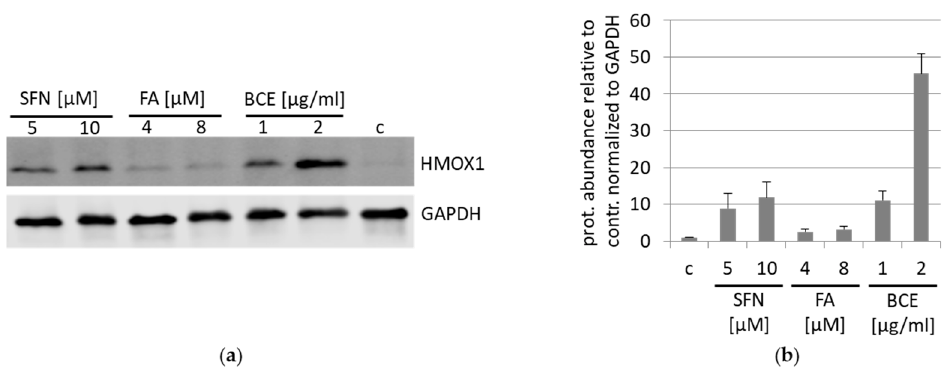
Figure 7. Induction of HMOX1 expression by different NRF2 inducers compared to BCE. ( a ) HeLa cells were treated with NRF2 inducer sulforaphane (5 µM, 10 µM SFN; 24 h), falcarinol (4 µM, 8 µM FA; 24 h) and with BCE (1 µg/mL, 2 µg/mL; 24 h) and compared to untreated cells. HMOX1 expression was examined by Western blot and normalized to GAPDH protein. One representative Western blot of four independent experiments with HeLa cells is shown. ( b ) HMOX protein abundance was quantified relative to a control and normalized to GAPDH. The data were presented as mean values with standard deviation from four independent experiments.